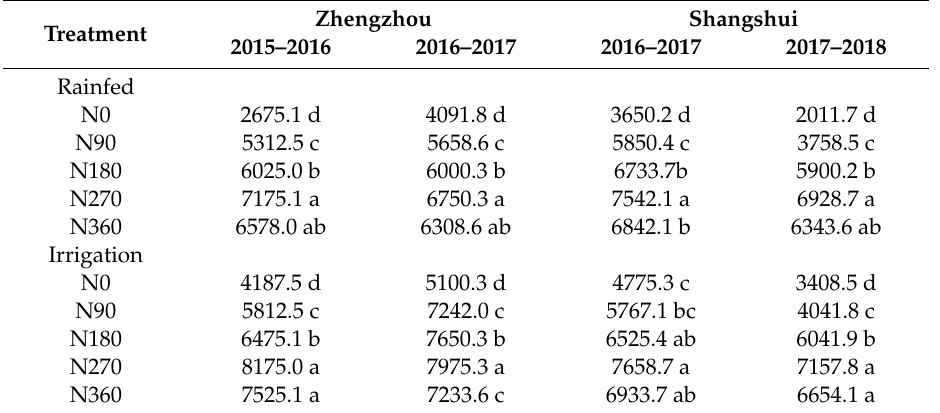
Table 7. E ff ects of N rate and irrigation regime on yield under di ff erent years and sites (kg hm − 2 ).